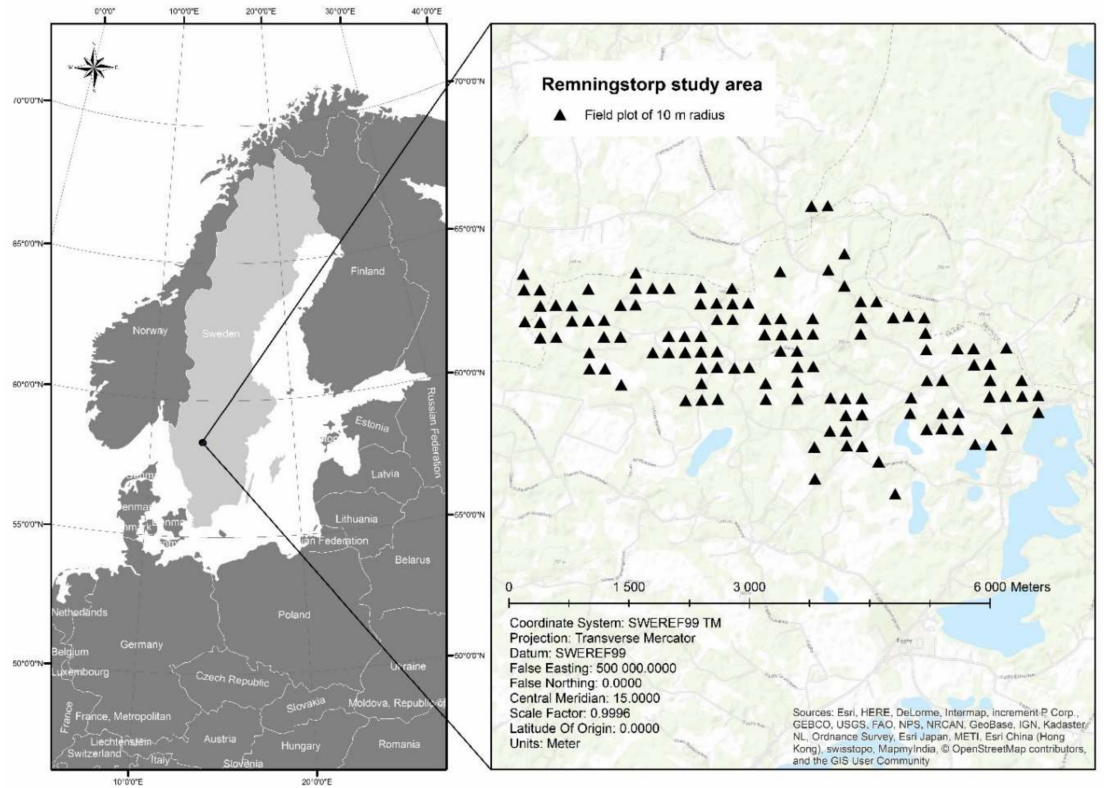
Figure 1. Overview of the Remningstorp test site in southern Sweden. The location of the 10 m radius sample plots which were used in the study are marked with black